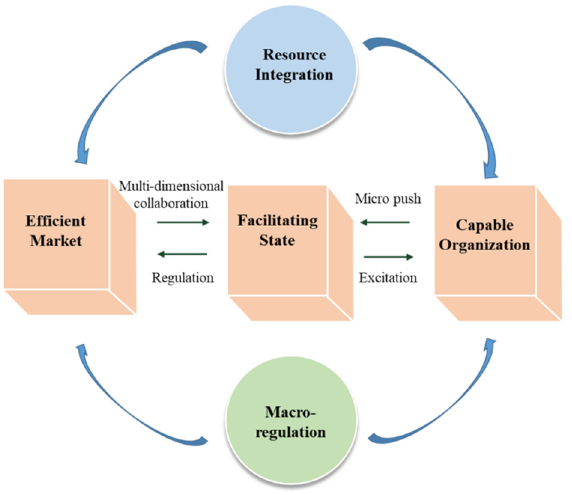
Figure 1. “Three Elements” analytical frameworks of new structural economics.